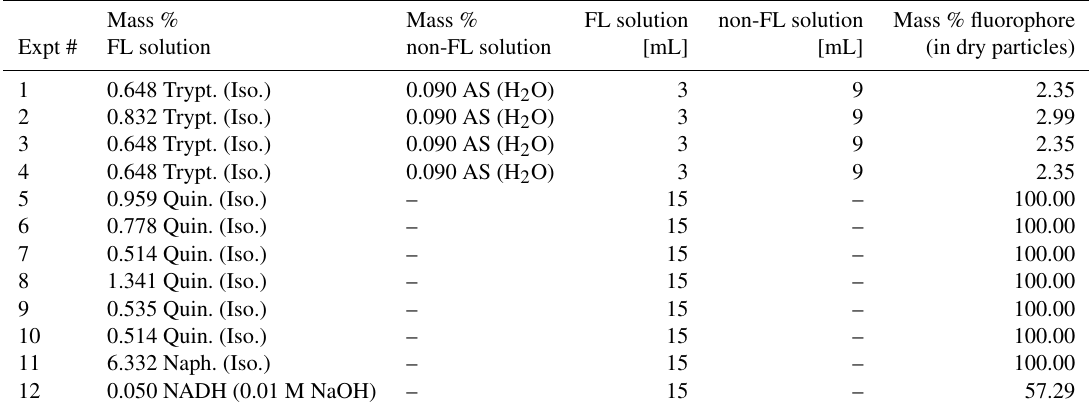
Table 1. List of gravimetric solutions used for calibration